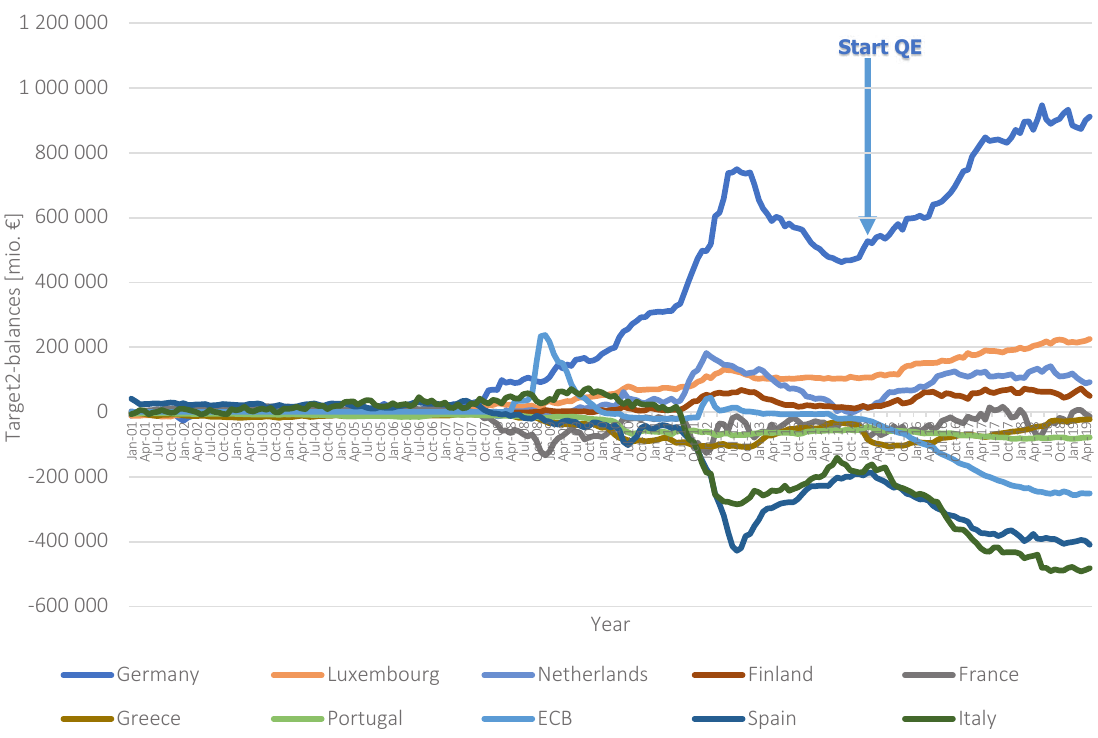
Figure 1. T2 balances in million EUR for selected countries: long-term and by